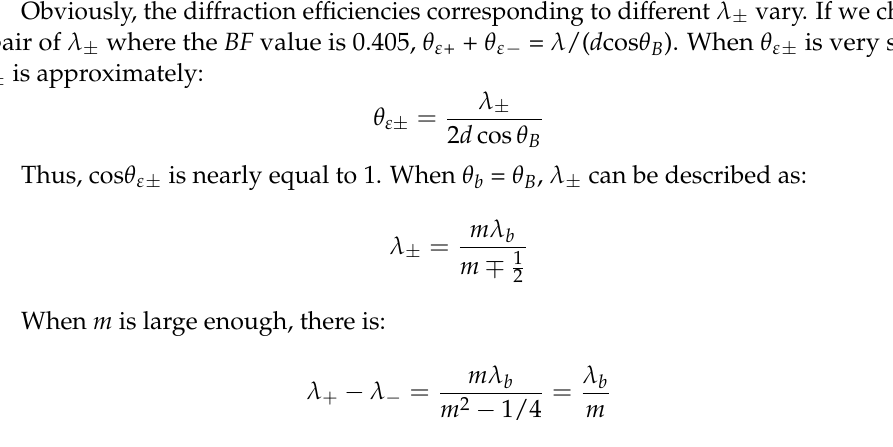
Figure 1. The diffraction schematic of the echelle.